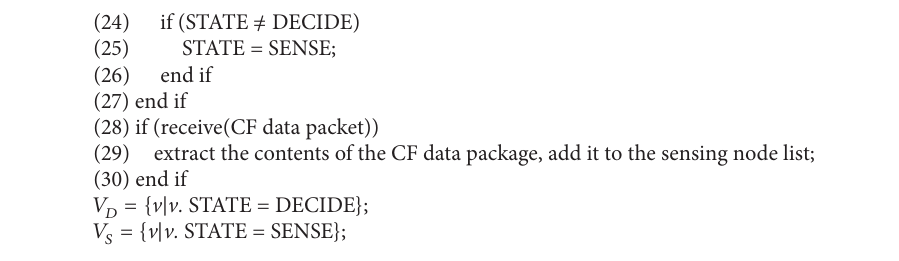
Algorithm 1: Construction algorithm of topology (CETC).